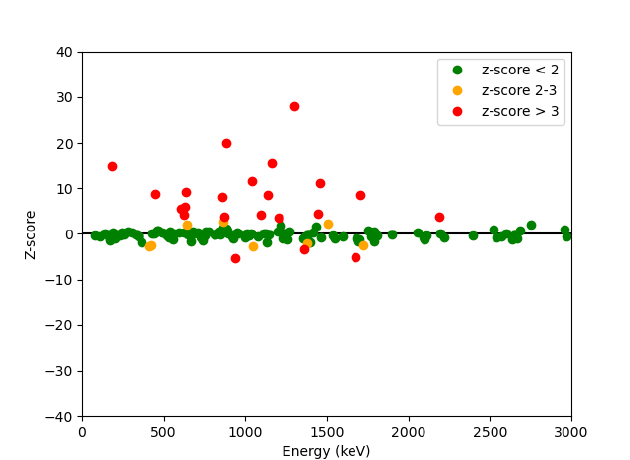
Figure 5. The peak area recovery z-score for the complex spectrum.